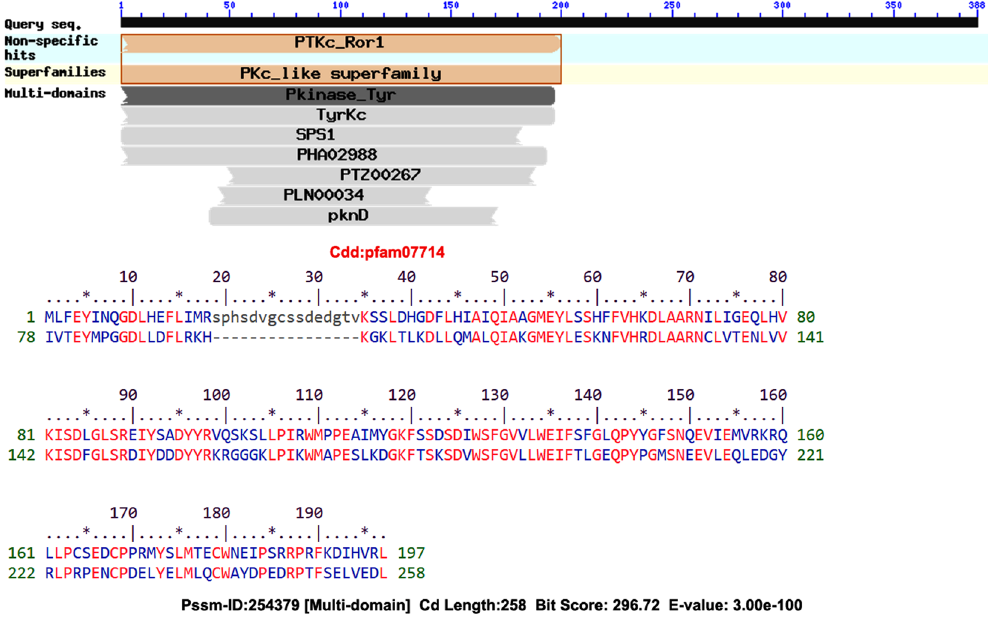
Figure 5. Domain Analysis by CD Search indicating similarity to tyrosine kinase domain.